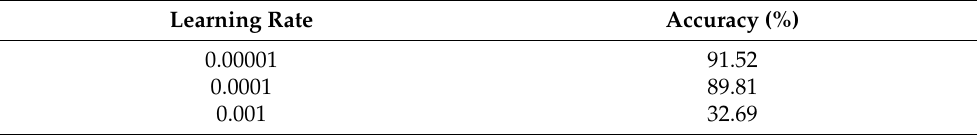
Table 5. The experimental results of different learning rates (GRU = 256, optimizer = Nadam).